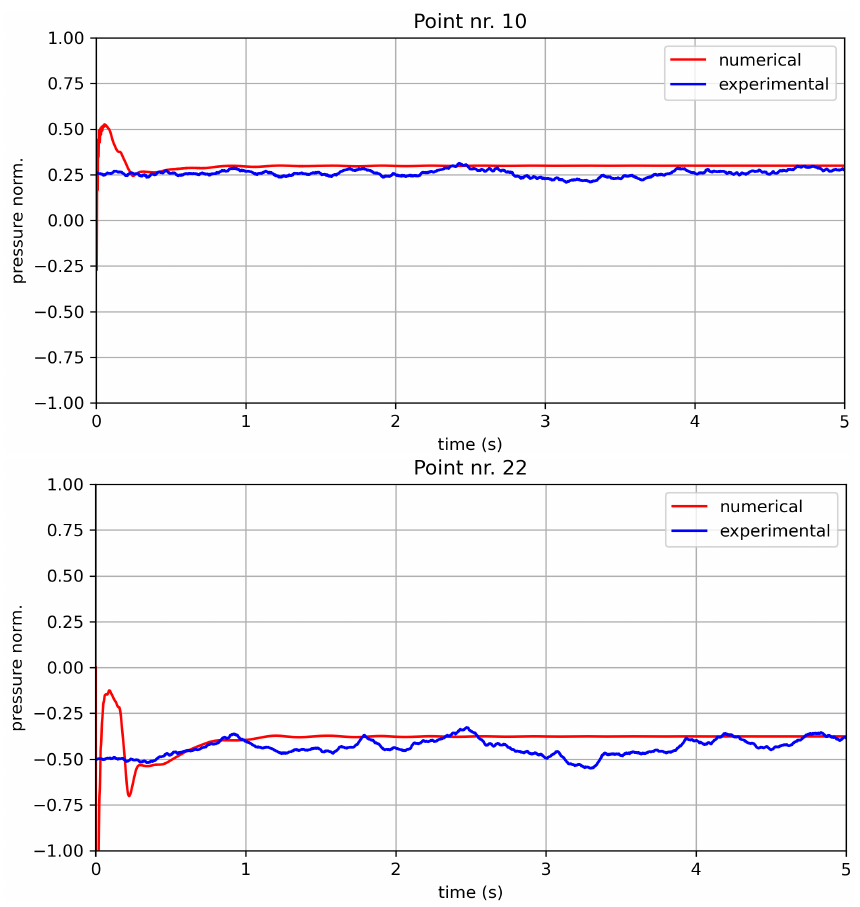
Figure 21. Numerical and experimental time histories of the pressure at P10 on the front surface (upper) and P22 on the rear surface (lower) for the 10 m/s